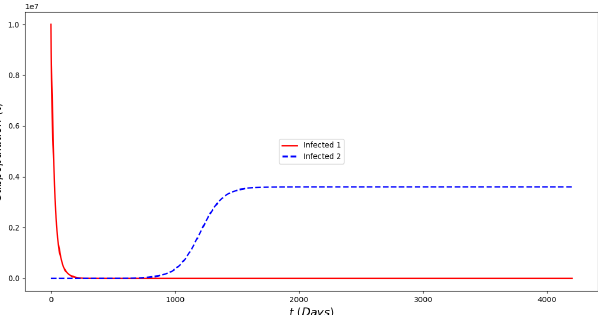
≈ 1.04 > R ≈ 0.9. The Omicron strain 0 1 2 despite the fact that the 1